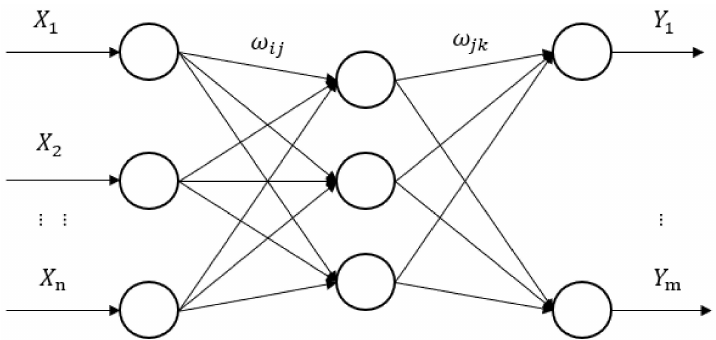
Figure 2. BP neural network topology